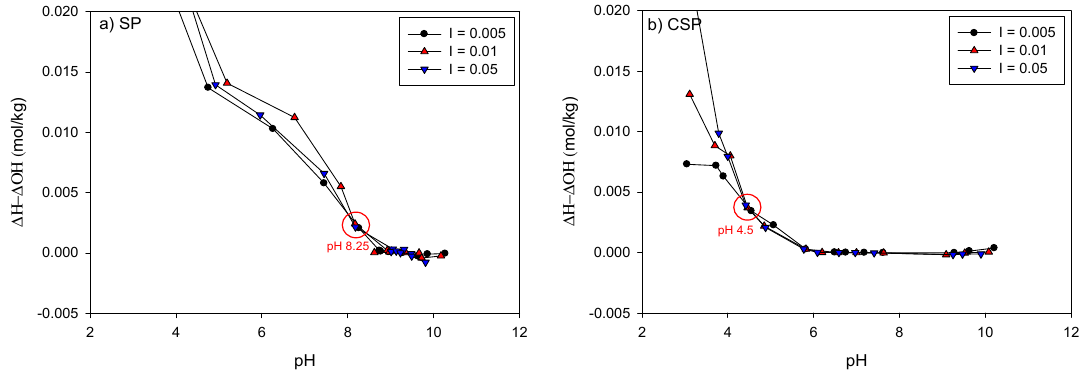
Figure 3. The point of zero charge (PZC) for ( a ) SP and ( b ) CSP.